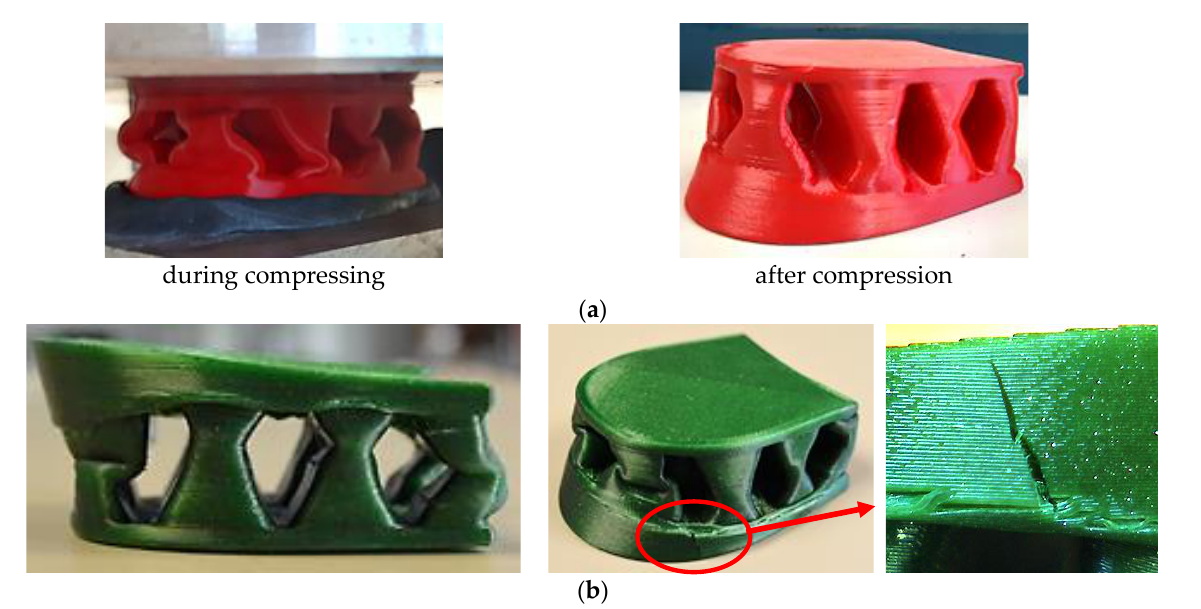
Figure 12. The samples of FDM-printed heel prototypes: ( a ) heels from TPC during and after compression test; ( b ) heels from PETG after compression test.